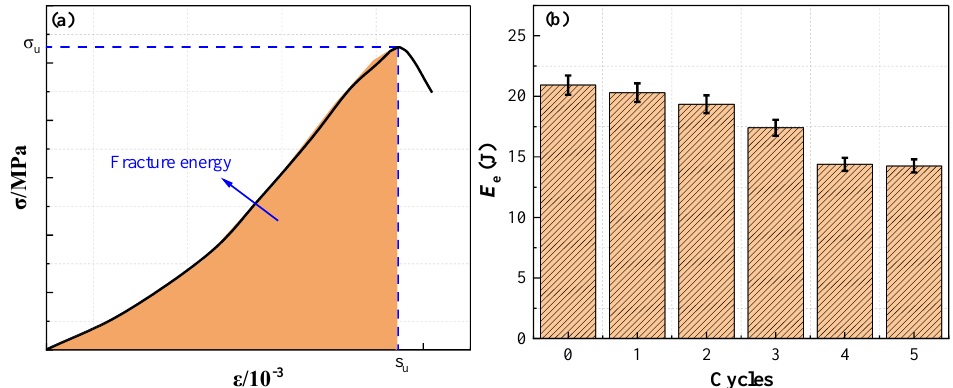
Figure 5. Fracture energy of specimens: ( a ) simplified illustration; and ( b ) fracture energy of specimens at different wet-dry cycles.